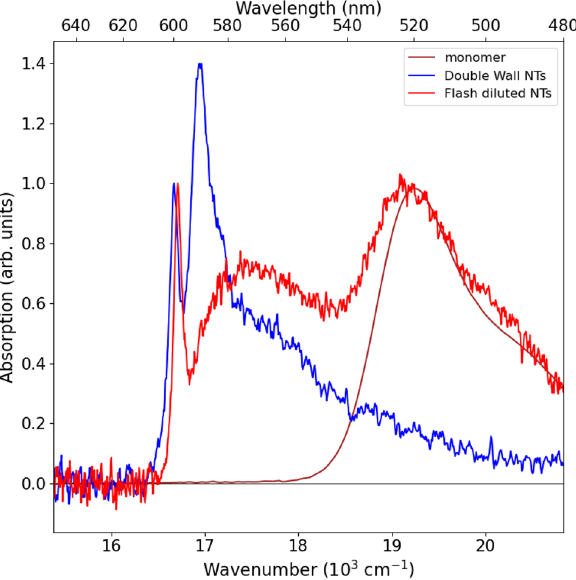
Figure 2. Absorption spectra of C8S3 monomers dissolved in methanol (brown), DWNTs (blue) and flash- diluted NTs (red). For the purpose of comparison, the spectra of DWNTs and flash-diluted NTs are normalised to the amplitude of the peak at ∼ 600 nm, while the monomer spectrum is normalised to the amplitude of the peak at ∼ 520 nm. Note a ∼ 40 cm −1 blue shift of the 600 nm peak of flash-diluted NTs with respect to the spectrum of DWNTs.